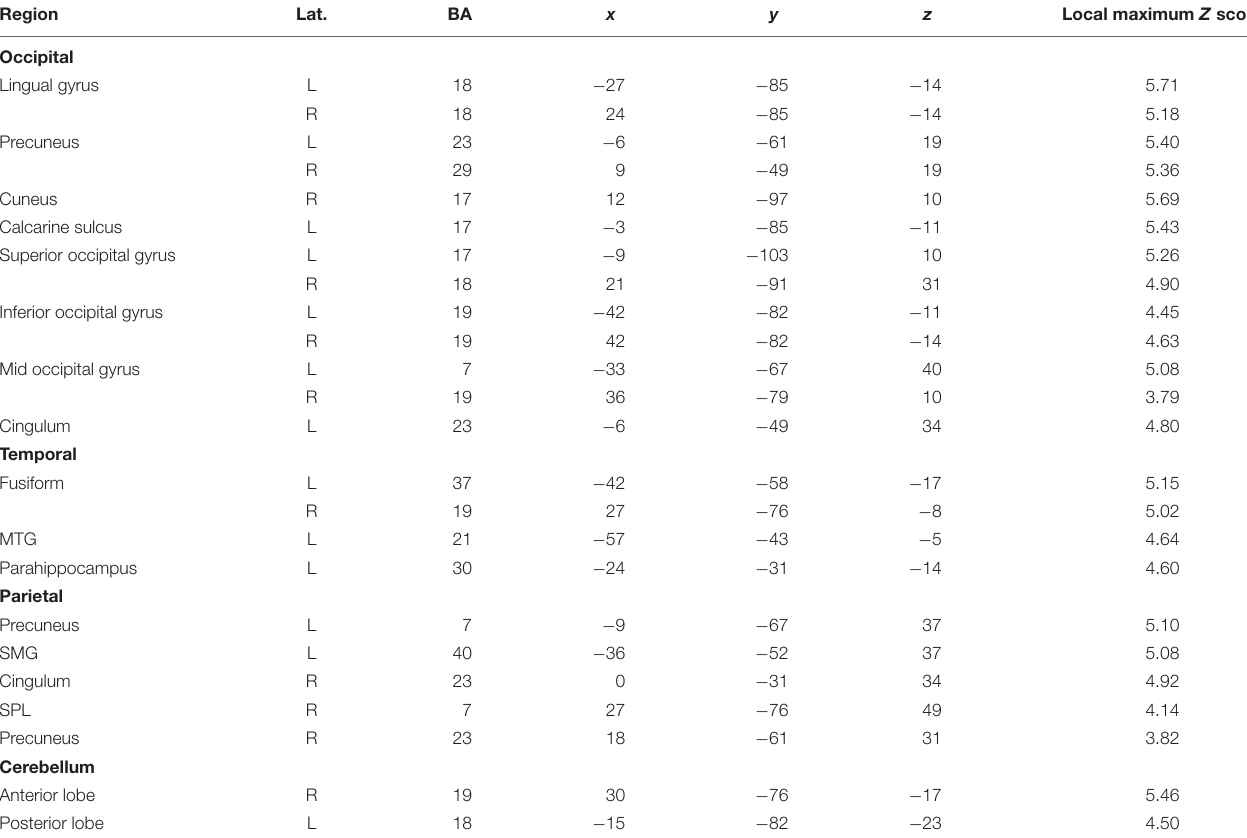
TABLE 4 | Local maxima from the major cluster activated during the memory substitution vs. no-think2 contrast. Region Lat.